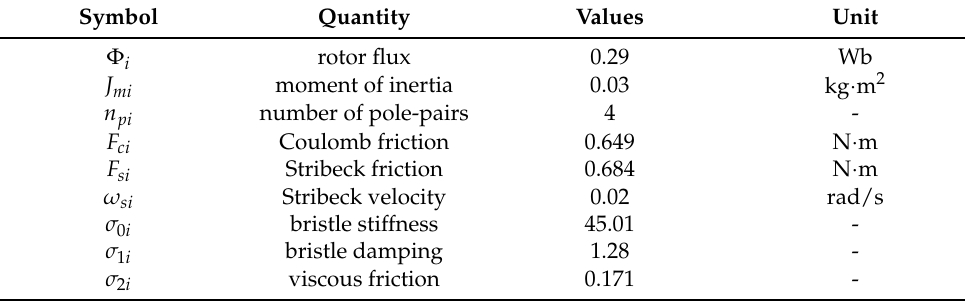
Table 3. Parameters of PMSM and LuGre